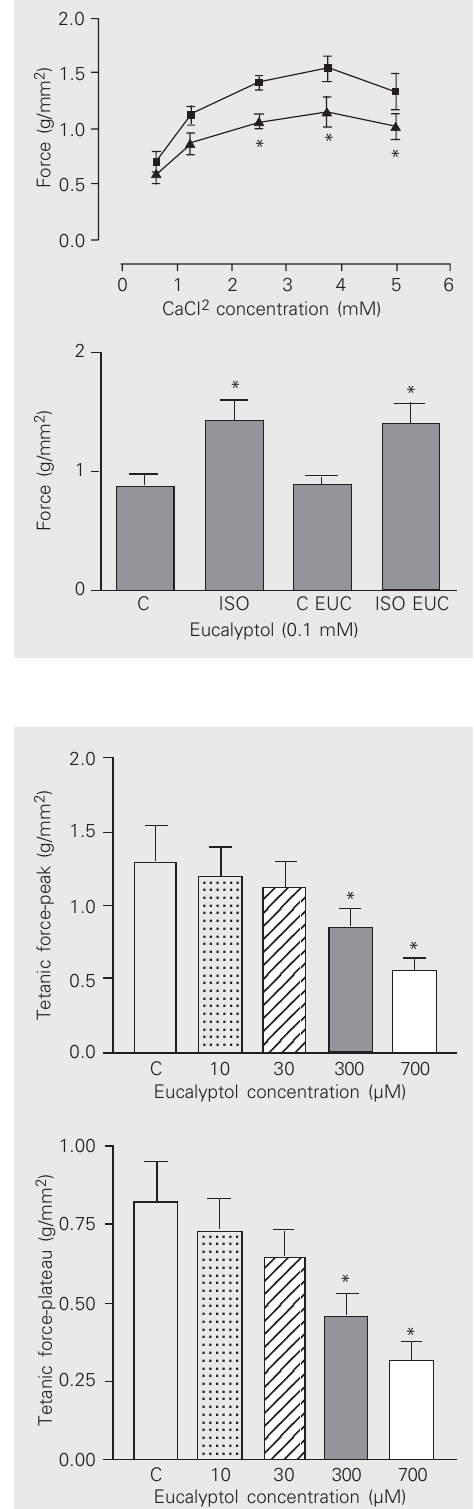
Figure 4. Effect of 0.1 mM euca- lyptol on the isometric force de- veloped by rat papillary muscles under increasing Ca 2+ concen- trations (upper panel). Data are reported as means ± SEM for N = 12. Randomized two-way ANOVA was significant compar- ing the two groups. *P < 0.05 compared to control (0.62 mM Ca 2+ ) both for control (squares) and eucalyptol-treated muscles (triangles). Lower panel , Effects of 0.1 mM eucalyptol on the iso- metric force developed after treatment with 20 ng/ml isopro- terenol by rat papillary muscles. Data are reported as means ± SEM for N = 12. C = control; ISO = isoproterenol; EUC = eucalyp- tol. *P < 0.01 compared to con- trol (0.62 mM Ca 2+ ; one-way ANOVA).